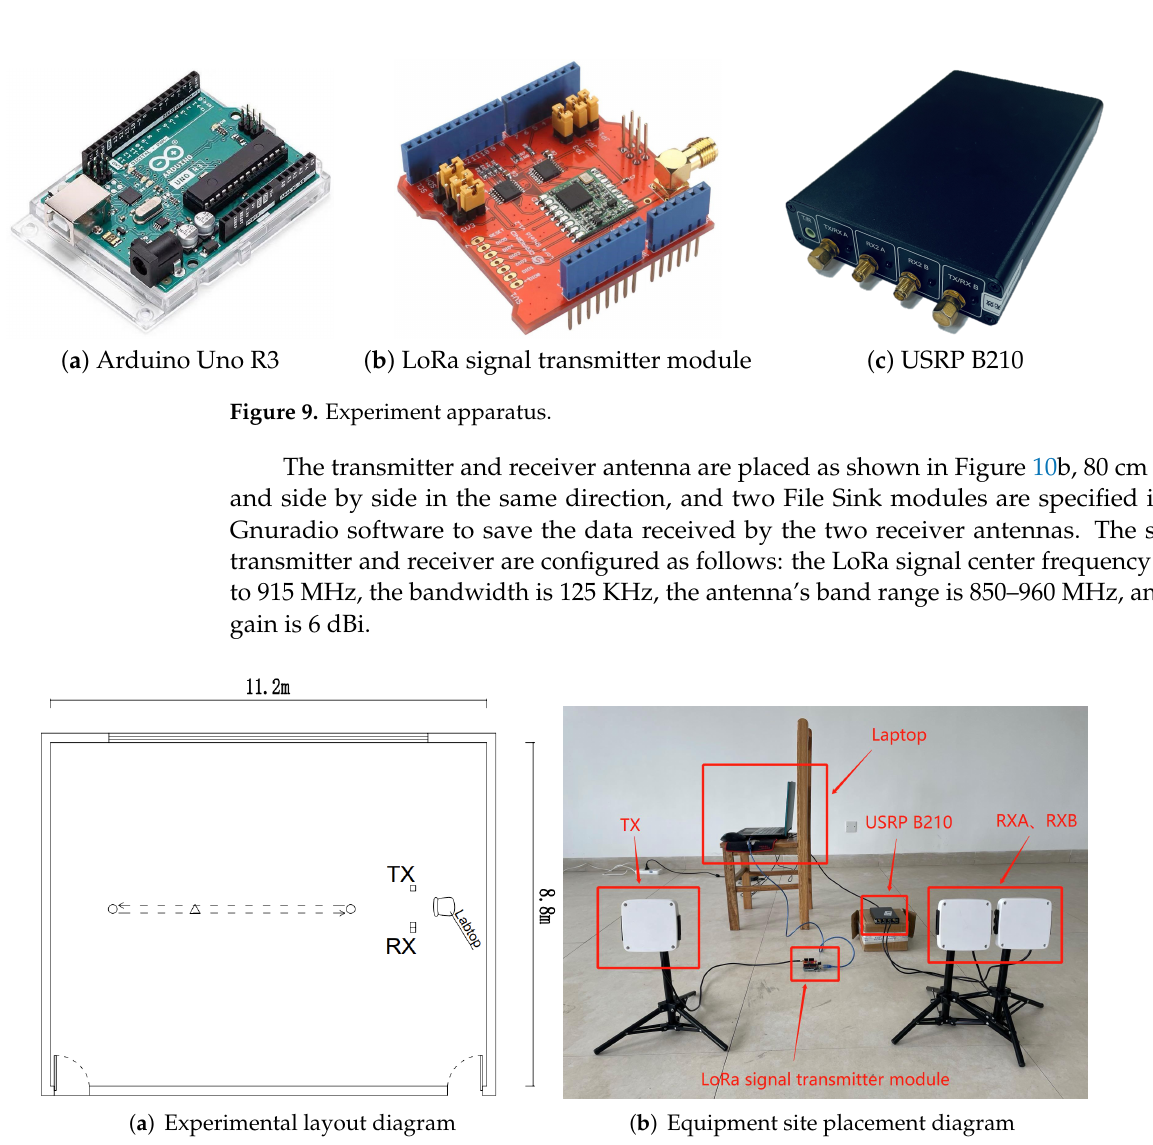
Figure 10. Experimental site layout